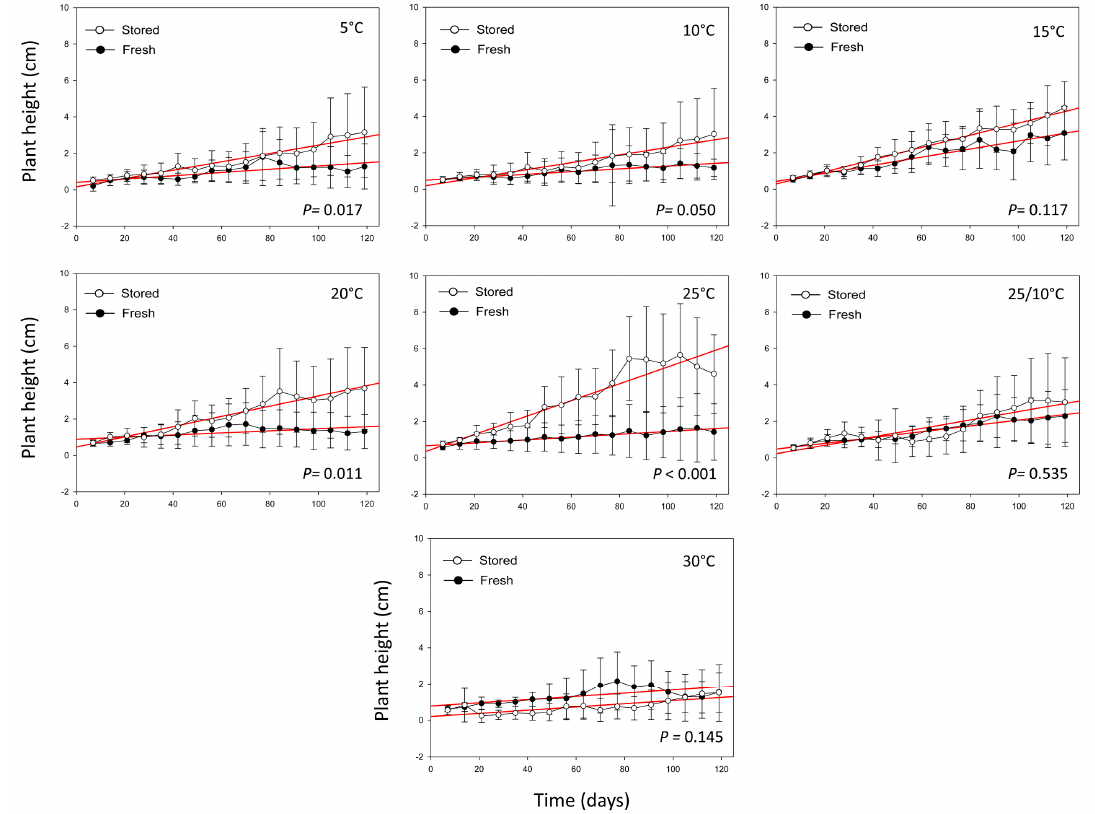
Figure 3. Seedling growth, expressed as plant height measured, by plants obtained from germinated seeds in each incubation temperature and seed condition (stored and fresh). Measures of plant height were expressed by time unit, according to the following equation: unit = cm × day − 1 . Red lines correspond to linear regressions.